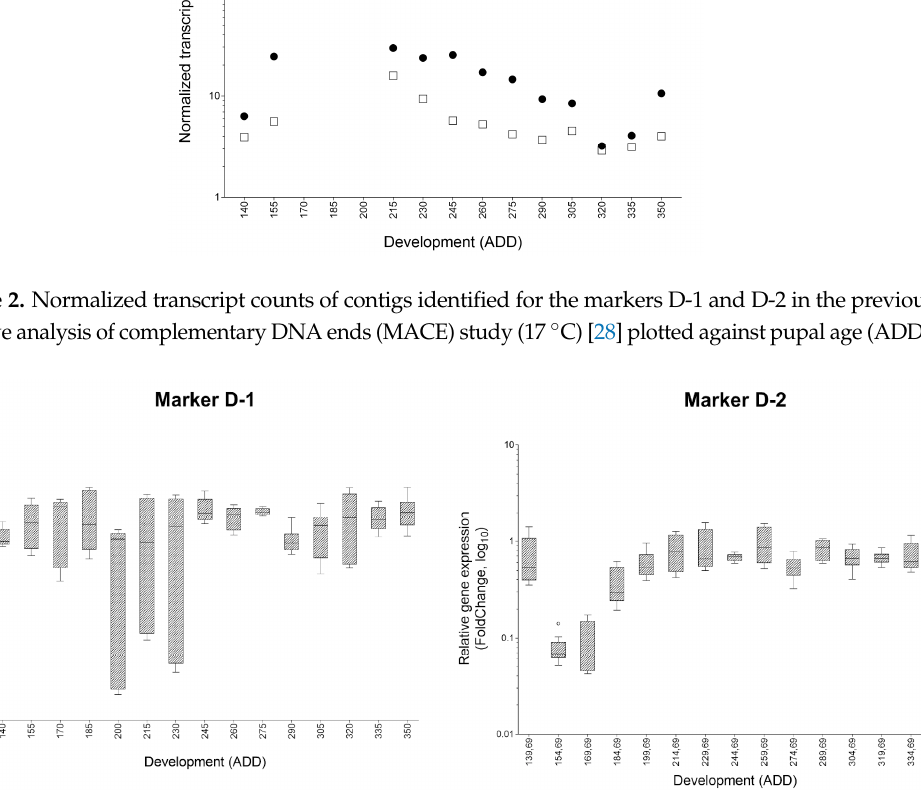
Figure 3. Tukey plots visualising the expression level of markers D-1 and D-2 showing no demarcated area of higher gene expression during metamorphosis under a temperature regime of 17 °C. FC values are plotted against pupal age (metamorphosis) in ADD. First sampling at 140 ADD is defined to be the first day of metamorphosis (white prepupa) and data were used as calibrator for FC calculation.